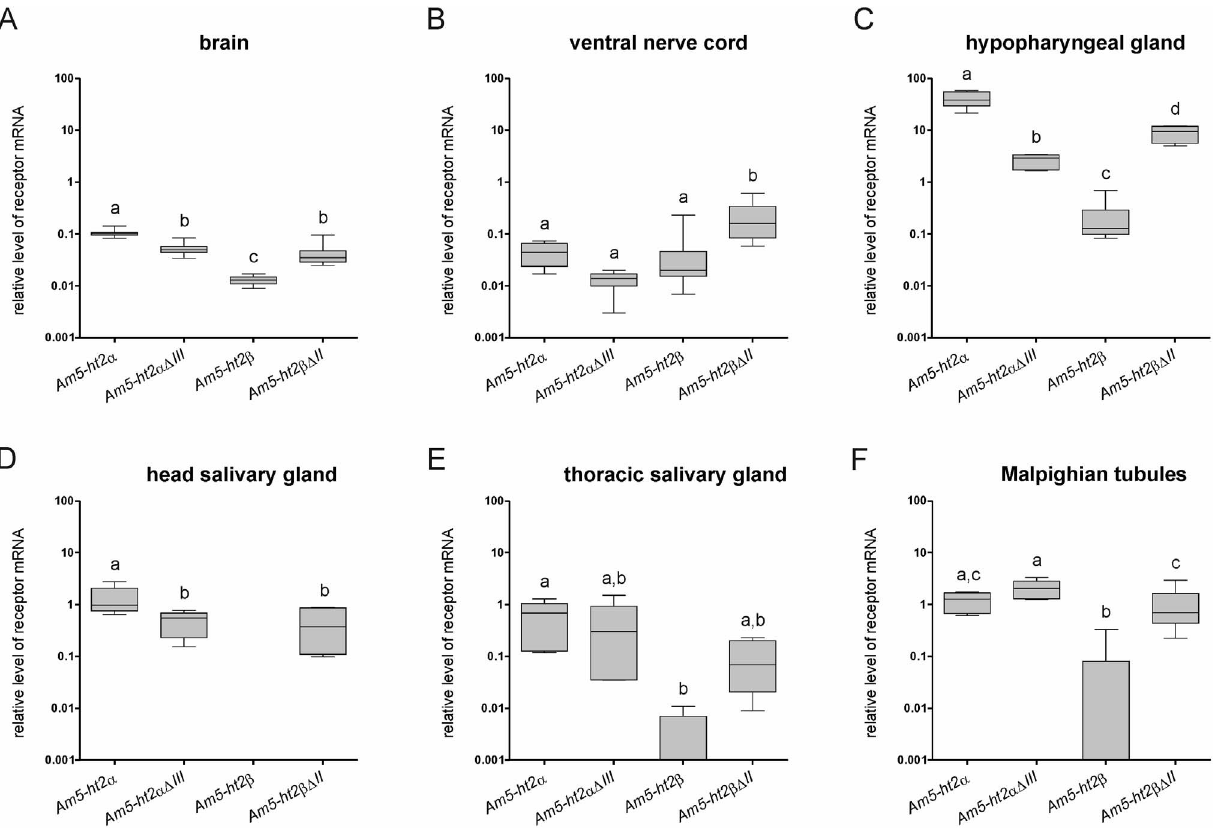
Figure 4. Tissue-specific expression patterns of Am5-ht2 receptor genes in pollen foragers determined by quantitative real-time PCR. Transcript levels were normalized to Amef-1 a . (A) Relative levels of receptor-gene mRNAs in the brain (n=11). (B) Relative levels of receptor- gene mRNAs in the ventral nerve cord ( Am5-ht2 a and Am5-ht2 aD III : n=11; Am5-ht2 b and Am5-ht2 bD II : n=10) (C) Relative levels of receptor-gene mRNAs in the hypopharyngeal gland ( Am5-ht2 a : n=6; Am5-ht2 aD III : n=5; Am5-ht2 b : n=7; Am5-ht2 bD II : n=6). (D) Relative levels of receptor-gene mRNAs in the head salivary gland ( Am5-ht2 a and Am5-ht2 aD III : n=5; Am5-ht2 b and Am5-ht2 bD II : n=7). (E) Relative levels of receptor-gene mRNAs in the thoracic salivary gland (each: n=5). (F) Relative levels of receptor-gene mRNAs in Malpighian tubules ( Am5-ht2 a : n=5; Am5-ht2 aD III : n=6; Am5 ht2 b : n=8; Am5-ht2 bD II : n=7). Groups that differed significantly from one another in relative mRNA levels are indicated with different letters above the box plots (p , 0.05, Bonferroni’s multiple comparison